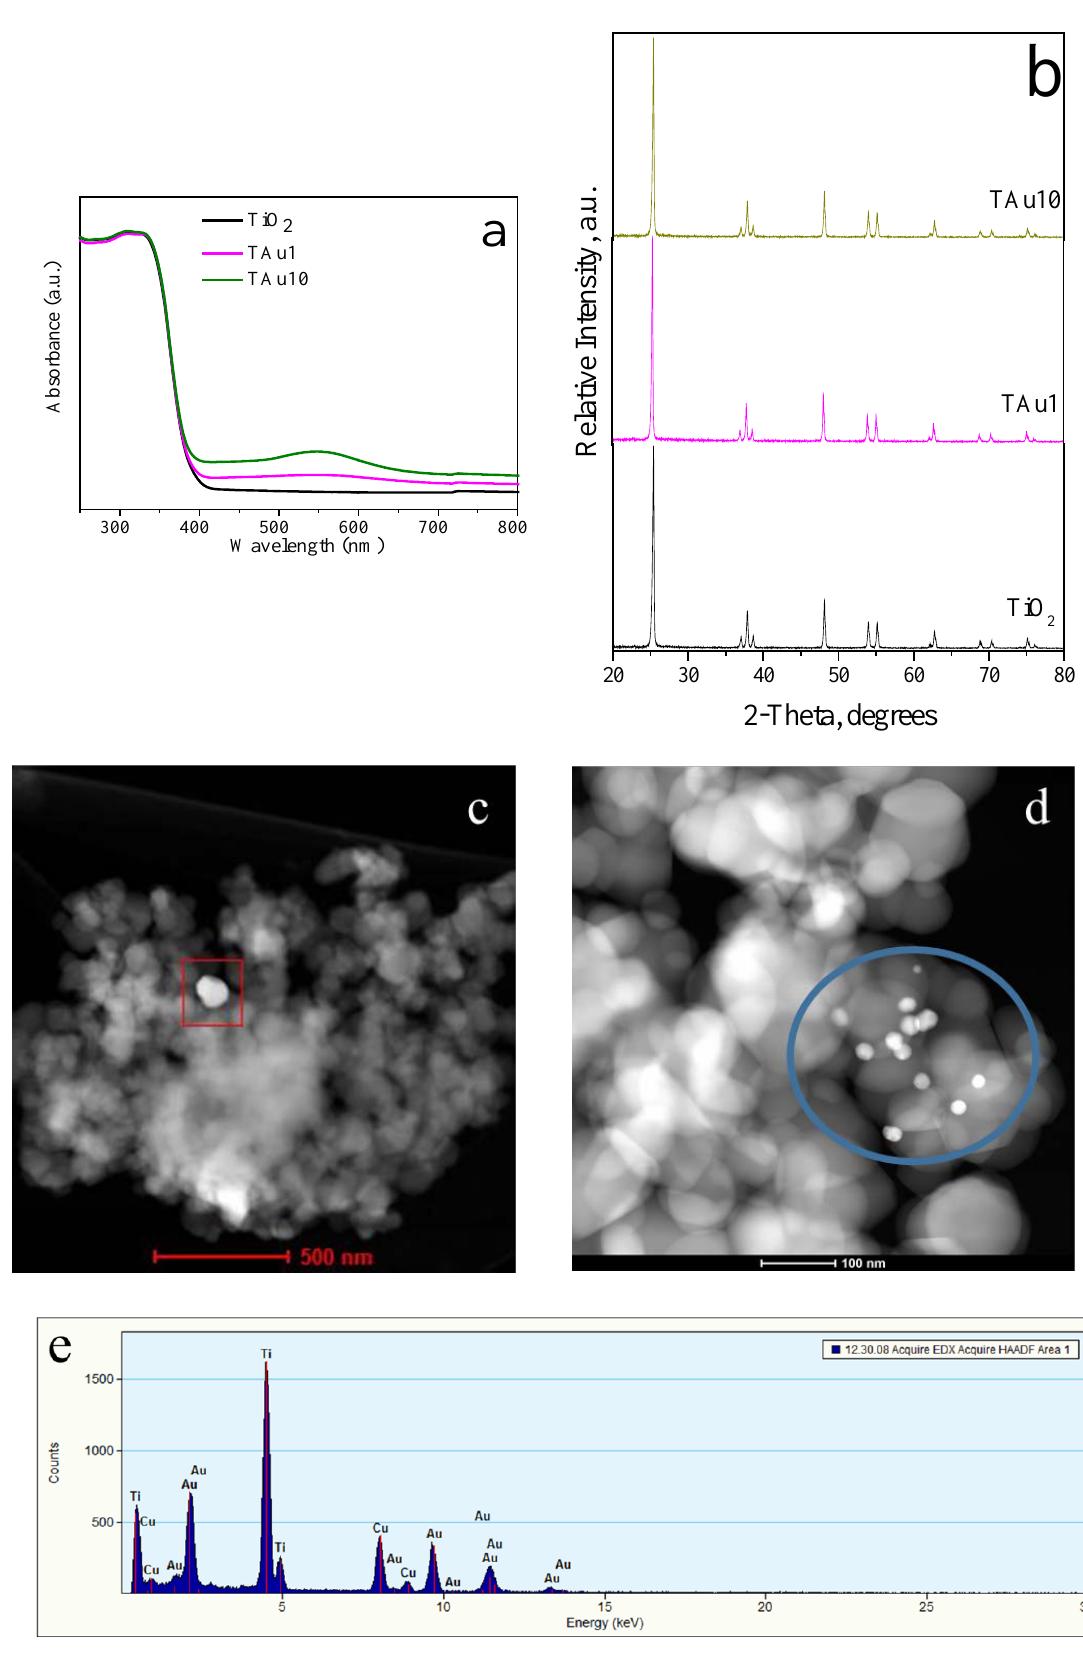
Figure 10. ( a ) DRS and ( b ) DRX of TiO 2 and TiO 2 decorated with NPs, ( c ) TEM of TAu1, ( d ) TEM of TAu10, and ( e ) EDS of